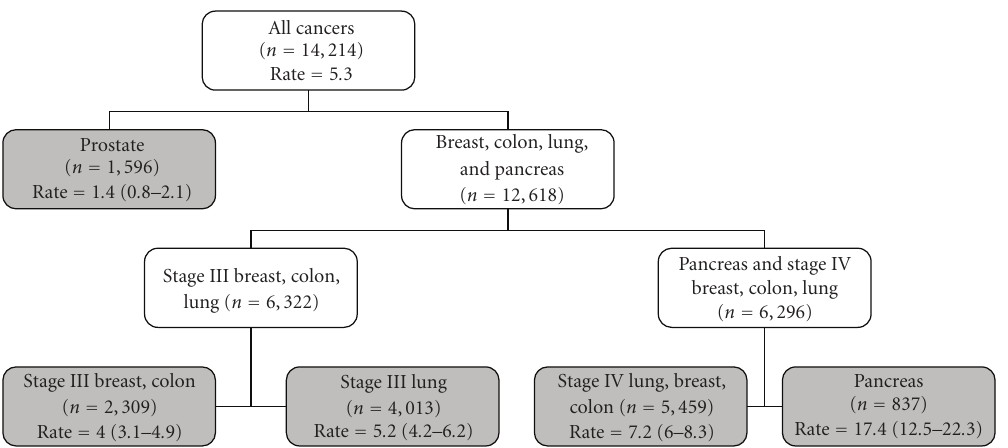
Figure 3: Recursive partitioning final analysis. Cancer of the prostate and pancreas is “nonlocalized.” Rates are number of VTEs per 100 person-years (95% confidence interval).